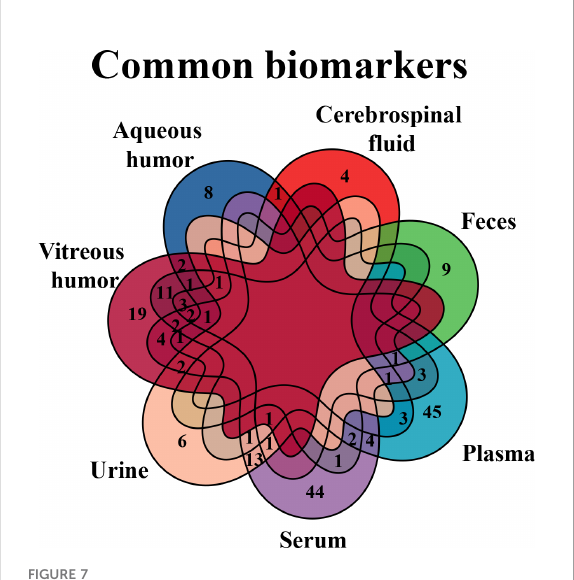
FIGURE 7 Venn diagram of common biomarkers in various biological samples. Common biomarkers of DR in various biological samples, but retina that is not applicable in clinic, were analyzed by Venn